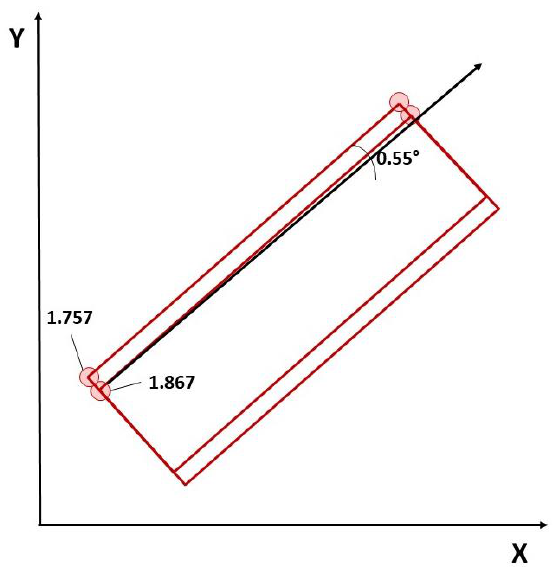
Figure 20. LiDAR point correction for the X and Y axes. In Figure 21, the same processing was applied for the translation along the Z axis. For this case, the value was 35 m.